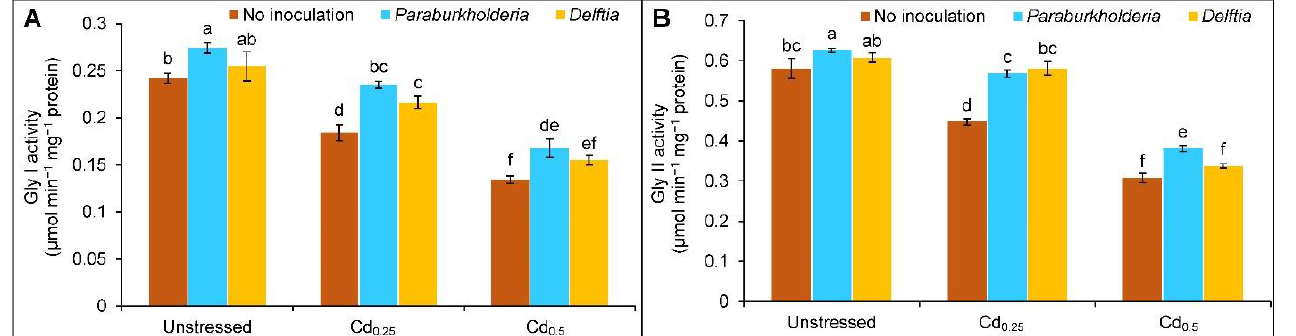
Figure 6. Effect of Paraburkholderia fungorum and Delftia sp. on the activities of ( A ) glyoxalase I (Gly